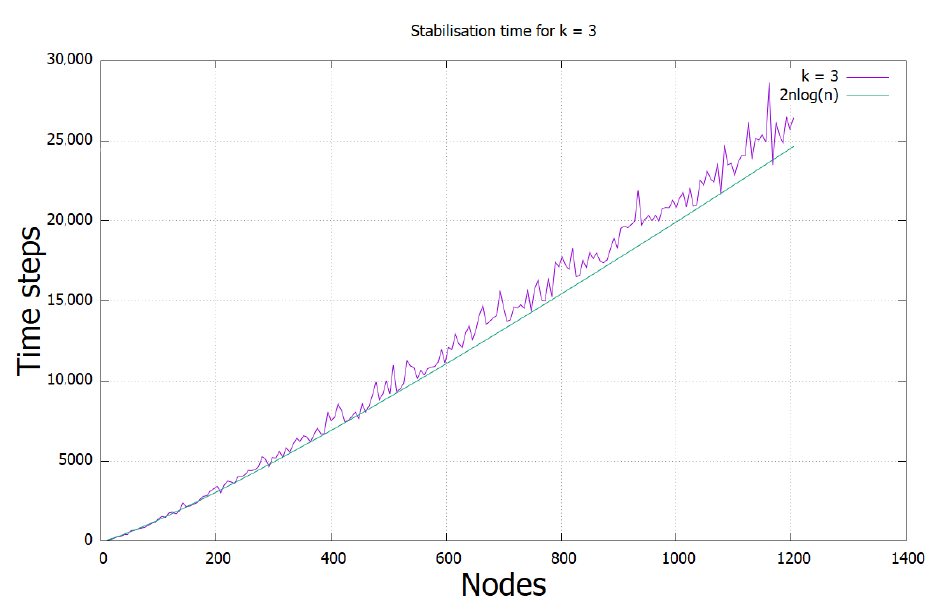
Figure 1. Running time of the protocol for k = 3, compared with a polylogarithmic function.